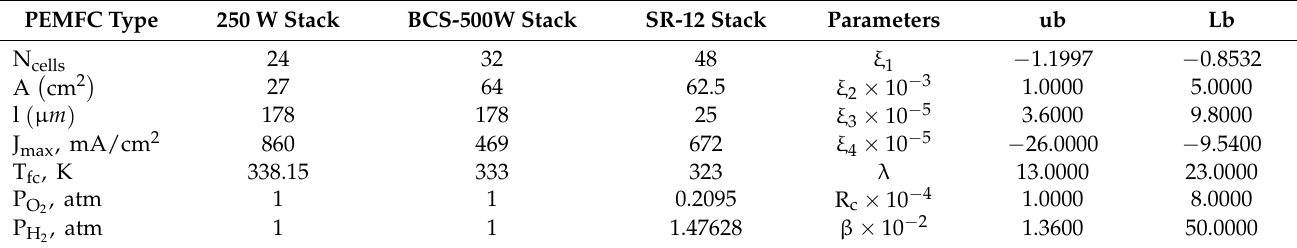
Table 2. Lb and ub of each unknown parameter in addition to the employed PEMFC